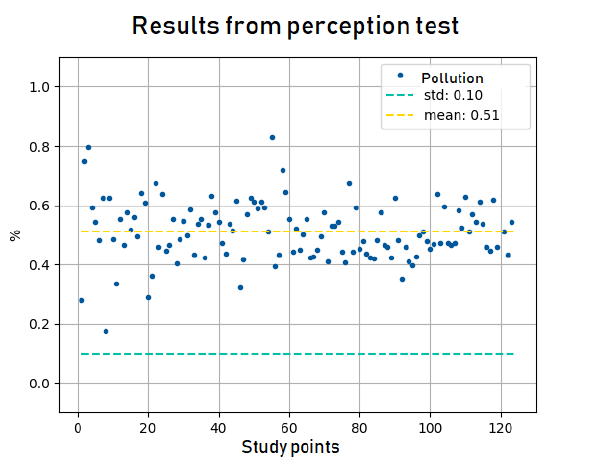
Figure 8. Pollution perceived from the points of study.